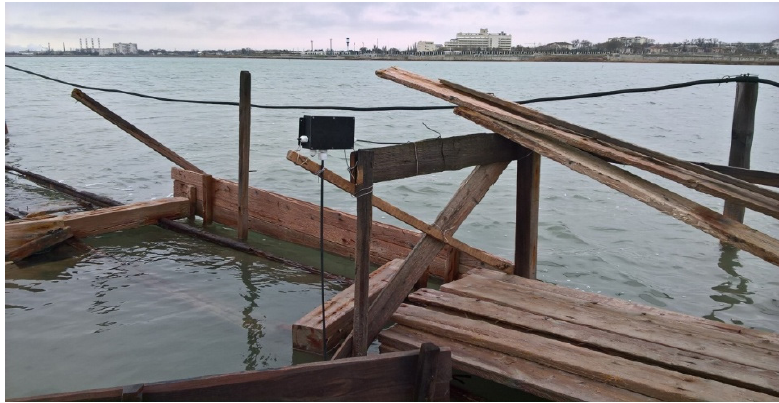
Figure 4. View of telemetry measuring system installation.